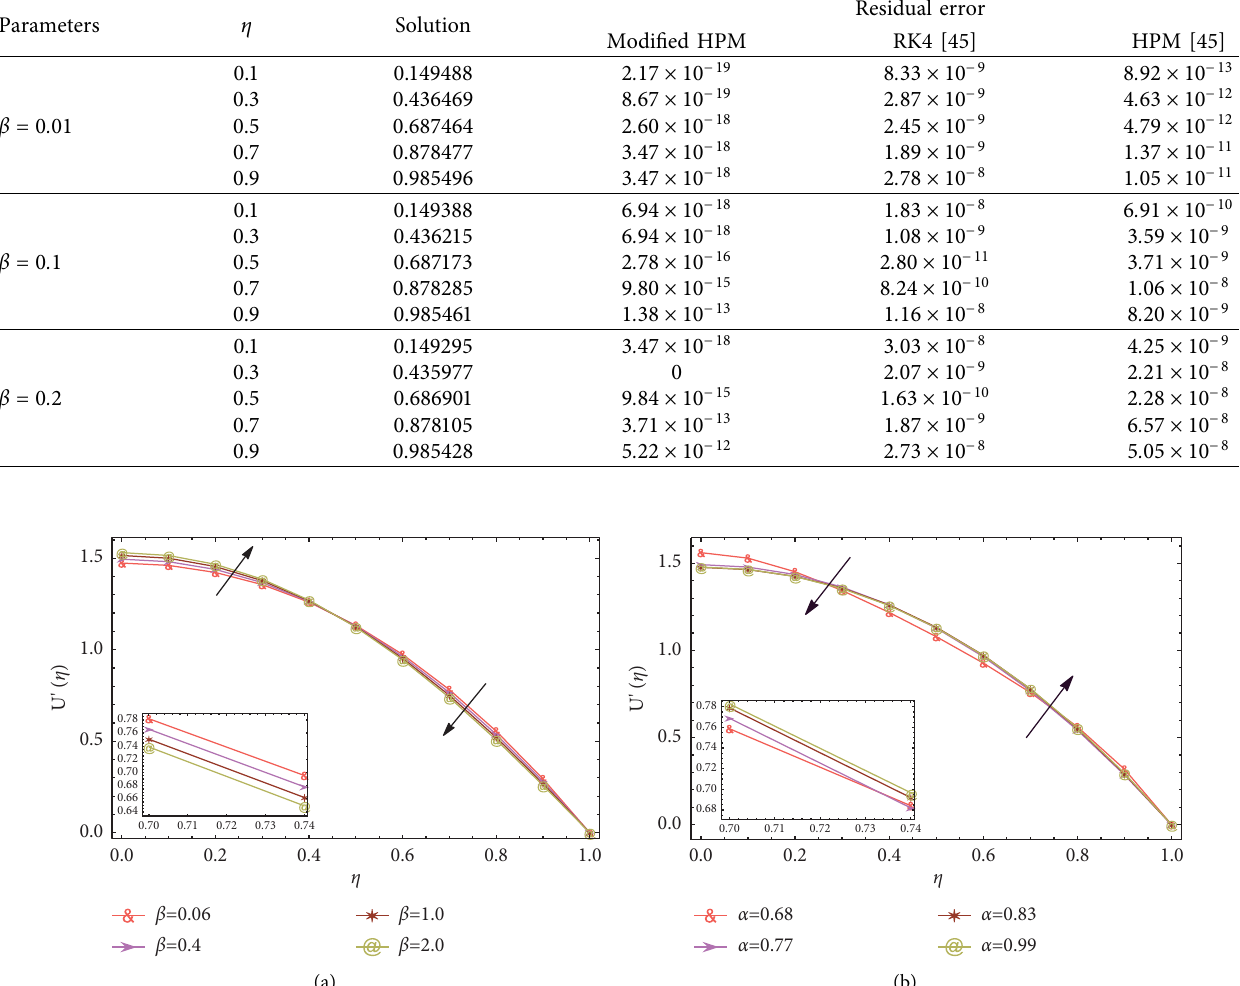
� 0 . 5 � κ � 0 . 05. t t , and β